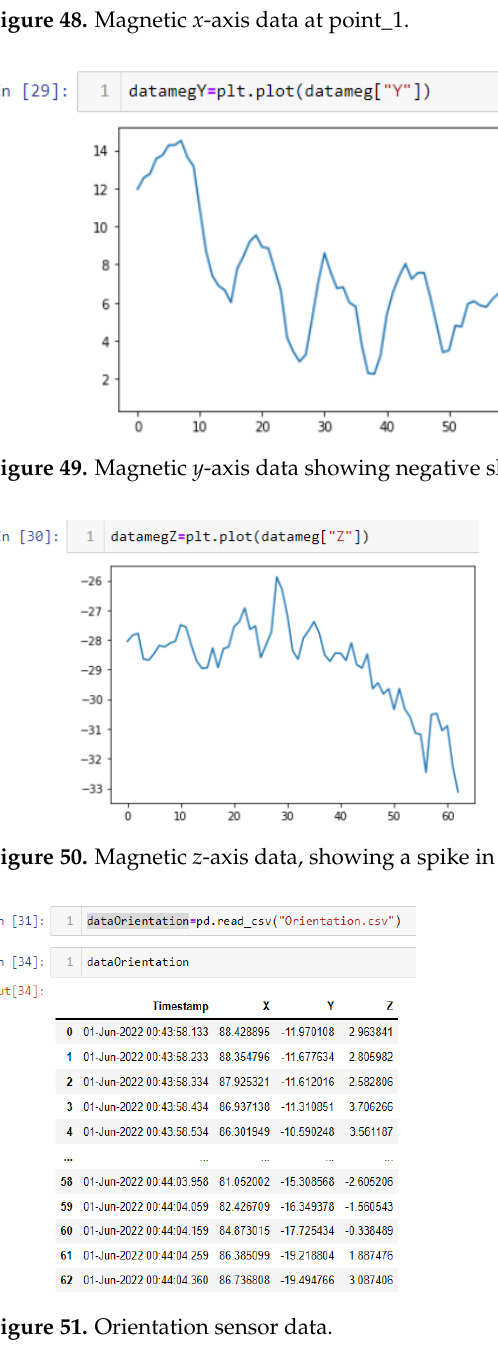
Figure 48. Magnetic x -axis data at point_1.